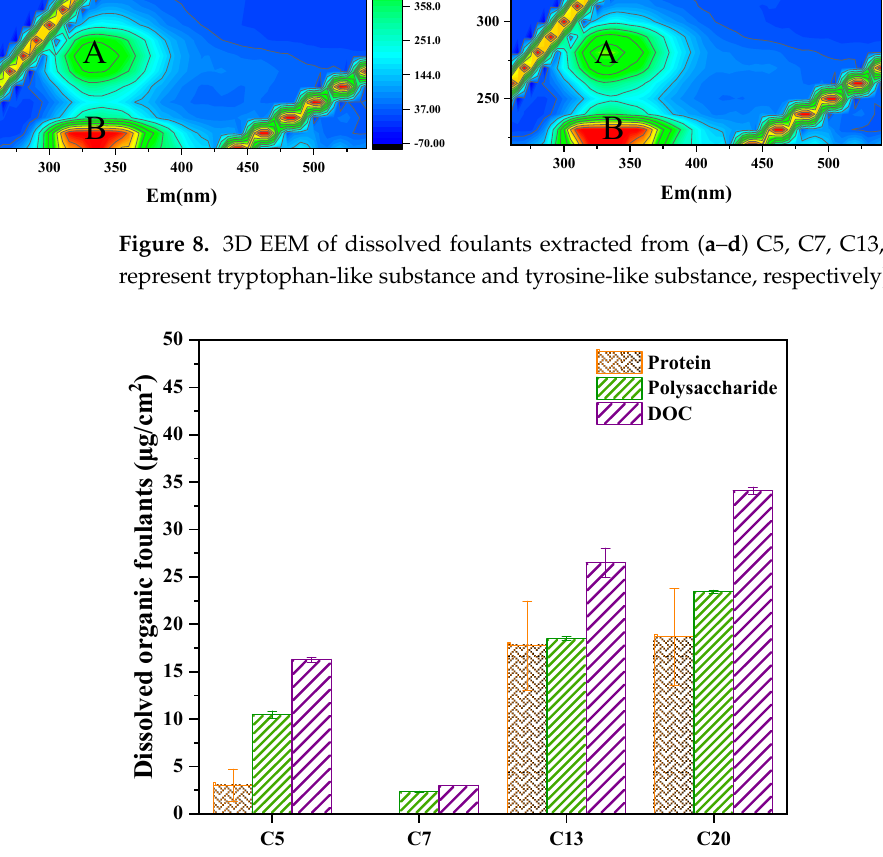
Figure 9. Protein, polysaccharide and DOC content on different membranes.